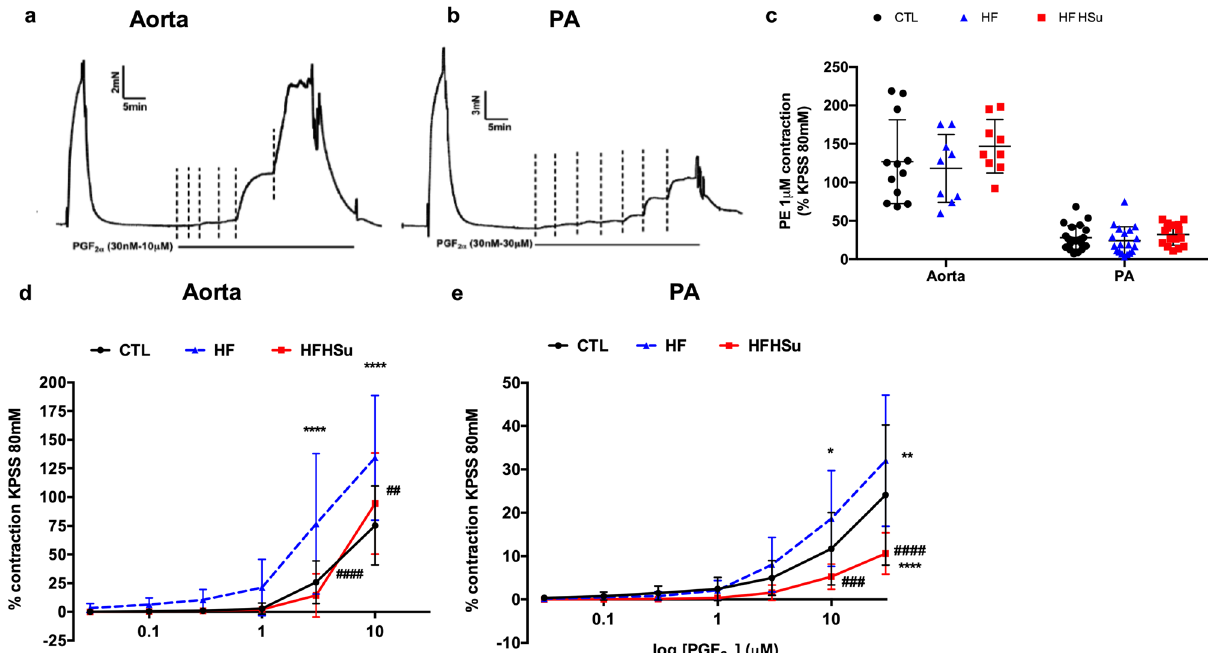
Figure 1. Effect of hypercaloric diets on vascular contractility in aorta and pulmonary artery (PA). Typical trace of aorta ( a ) and pulmonary artery ( b ) in response to a stimulus of KPSS 80 mM for 3 min, and a dose response curve to different concentrations of PGF 2α . ( c ) Average of the 3 min response to phenylephrine (PE) 1 µM (in PA (n = 15–52) and aorta (n = 9–16) of control, HF and HFHSu animal groups. ( d ) Dose response to PGF 2α (0.03– 10 µM) in aorta of control, HF and HFHSu (n = 10 for all) animals. ( e ) Dose response to PGF 2α (0.03–30 µM) in PA of control (n = 21), HF (n = 12) and HFHSu (n = 7) animals. Values are presented as mean ± SD. One-way ANOVA with Dunnet’s Multiple Comparison test. * p < 0.05, ** p < 0.01 and **** p < 0.0001 versus control animals; # p < 0.05, ## p < 0.01, ### p < 0.001 and #### p < 0.0001, HF versus HFHSu